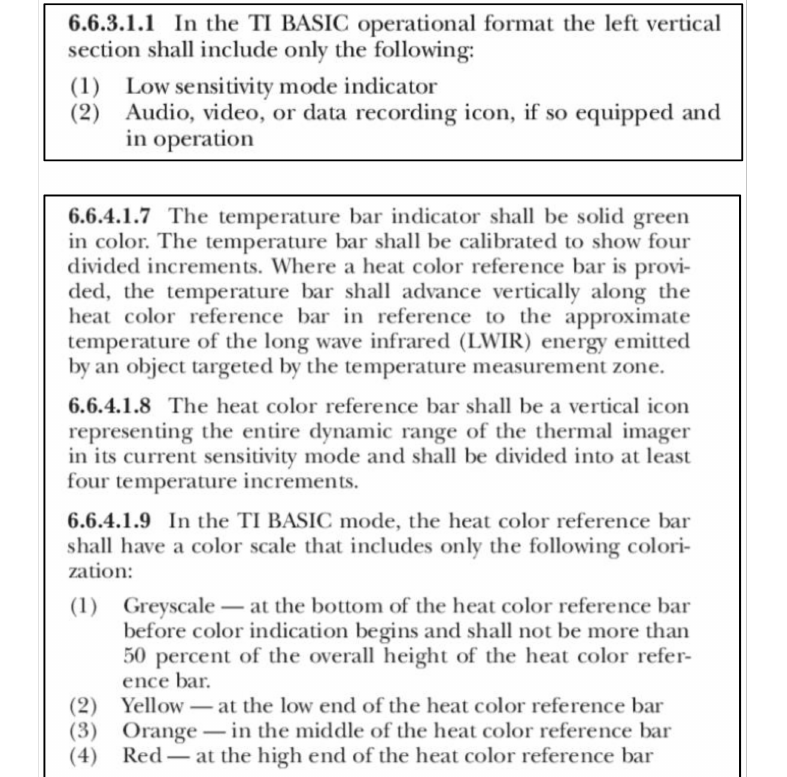
Figure 4. Definition of NFPA1801 for TIC sensitivity and temperature colorization bar [10].